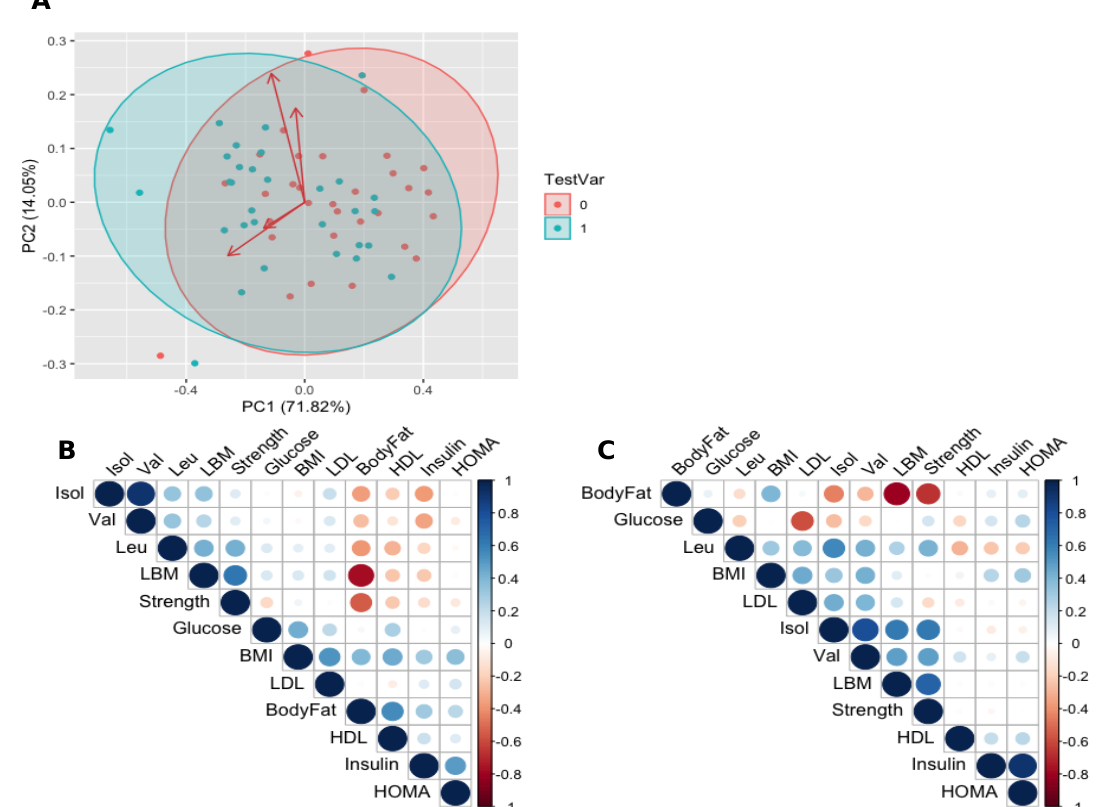
Figure 4. Principle component analysis (PCA) plot visually displaying overlap of clinical variables of health; no distinctive clustering of metabolites predicative of circulating branched chain amino acid (BCAA) concentrations are present at baseline (red), nor emerge following resistance exercise training (RET) (green) ( A ). Heatmap of correlations that are predictive of circulating BCAA concentrations at baseline ( B ) and after RET ( C ). The strength of relationships are based on a scale of − 1 (red), representing a negative relationship and 1 (blue) a positive relationship. The strength of the relationships are depicted by the size of the circle.